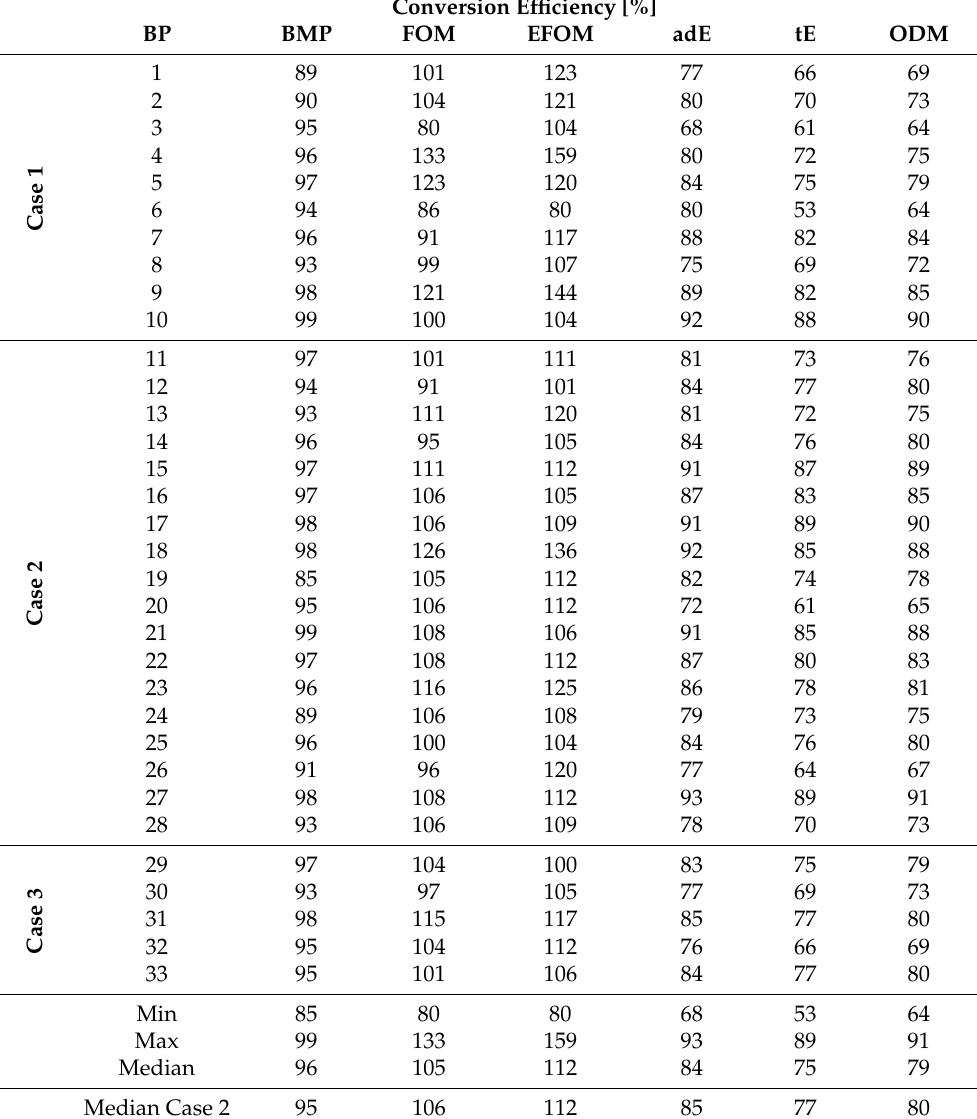
Table 3. Conversion efficiency (CE) of 33 biogas plants (BP) determined by biochemical methane potential test (BMP), fermentable organic matter (FOM), energy fermentable organic matter (EFOM), anaerobically degradable energy (adE), total energy (tE) and organic dry matter content (ODM). The minimum (Min), maximum (Max) and median value were calculated for each parameter. The median of BP fitting Case 2 were also calculated. BP 12 is a research biogas plant with high measurement